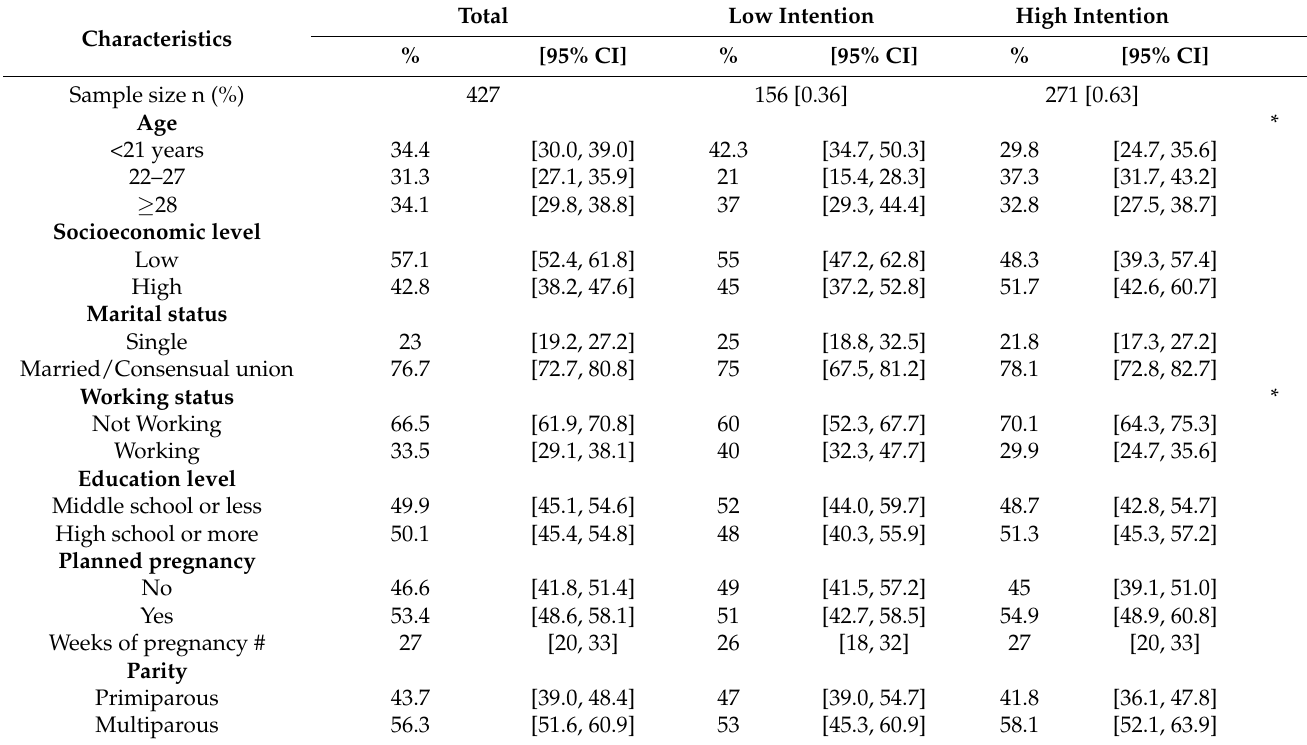
Table 2. Sample characteristics stratified by level of breastfeeding intention of development sample a